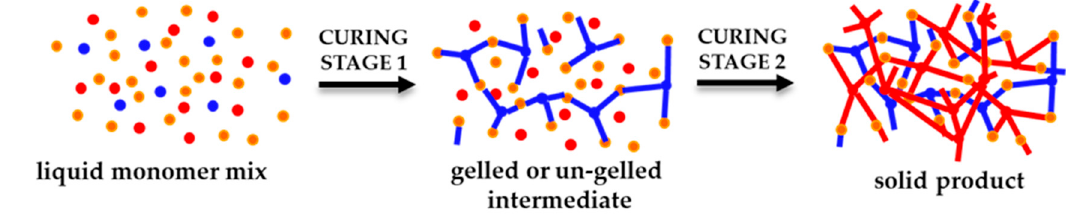
Figure 6. Schematic representation of a sequential dual-curing process.